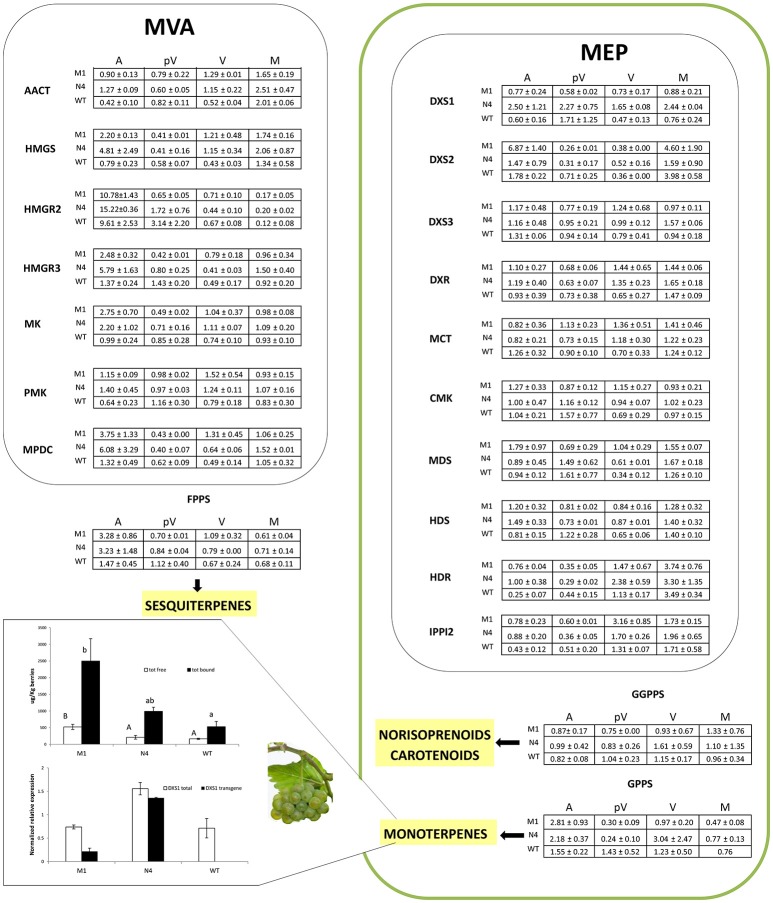
Transcription profile of specific genes of the MEP and MVA pathways during berry development (see matrix) and monoterpene content vs. VvDXS1 transcript level in mature fruits (see histograms). For the time-course expression profiles, the raw Cq values from TaqMan card assay were elaborated according to Hellemans et al. (2007) and numbers in the cells are the mean of two biological replicates ± SE. The full gene name corresponding to each acronym can be retrieved in Figure 4. Monoterpene content was assessed in berry skin of fruits collected at technological maturity in 2016 (Table S2) and concentration values in the upper histogram are the mean ± SE of four biological replicates. The letters on the bars indicate different subsets according to ANOVA and Tukey's HSD post-hoc tests (P < 0.05). A portion of the skin powder grounded for metabolic analysis was used to quantify VvDXS1 expression and values in the lower histogram are the mean ± SE of two (for WT) or three (for M1 and N4) biological replicates. M1 = Mi-M1, N4 = Mi-N4, A, flowers at anthesis; pV, berries at pre-veraison; V, berries at veraison; M, berries at maturity.